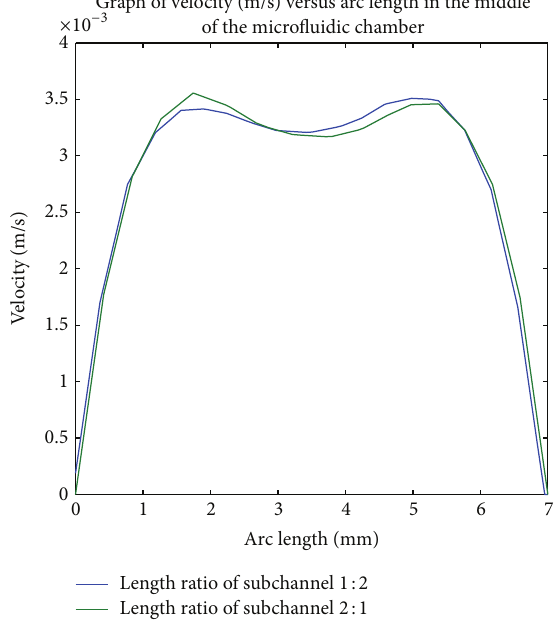
Figure 6: Graph of velocity versus arc length in the middle of microfluidic chamber (subchannel length ratio 1:2 & 2